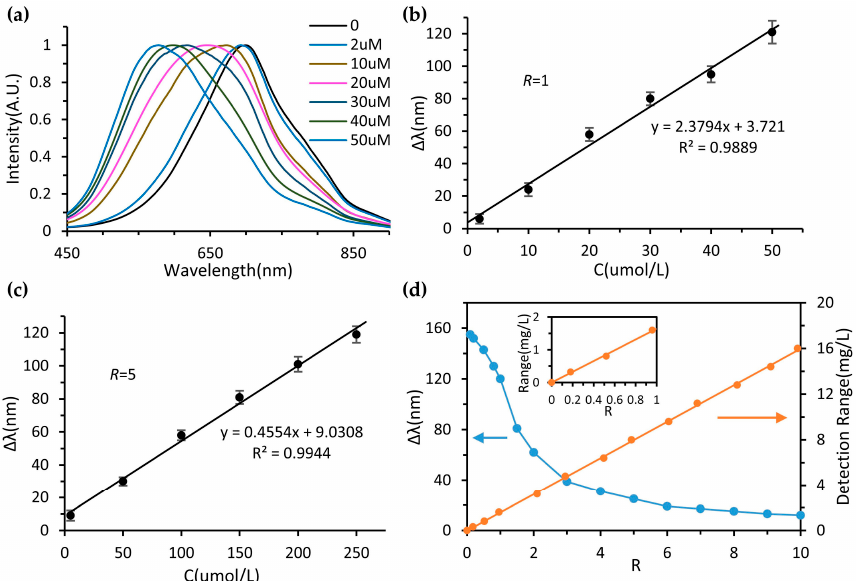
Figure 5. ( a )Normalized SPR extinction spectra of the Ag nanoprism with di ff erent DO concentrations. Plots of SPR peak shift ( ∆ λ ) vs. concentrations of DO at di ff erent flow rates, ( b ) r == 1, ( c ) r = 5. ( d ) The blue line shows the relationship between SPR peak shift ( ∆ λ ) and flow rate ratio ( r) when the concentrations of DO was fixed at 50 µ M (1.6 mg / L). The orange line shows the detection range adjustment by changing r . The insert is an enlarged graph of the relationship between detection range and r (0–1).